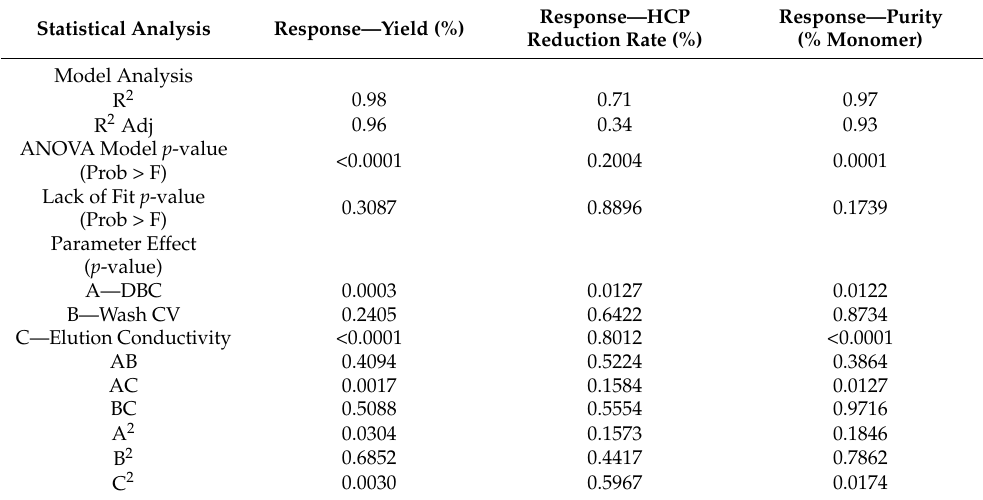
Table 4. Statistical analysis for the proposed CCF design. p -value < 0.05 is considered significant. Statistical